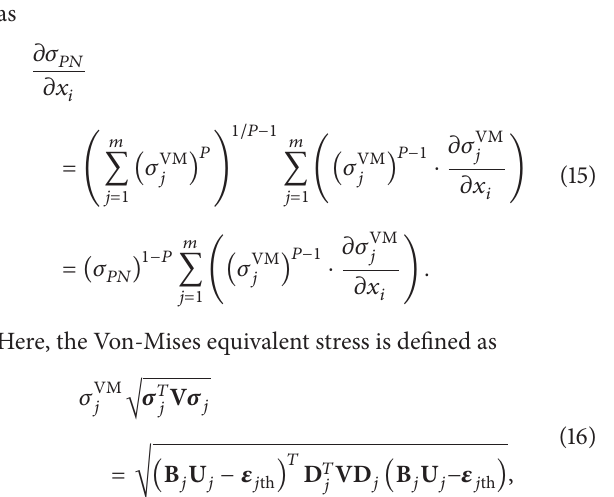
Table 2: Material properties used in the